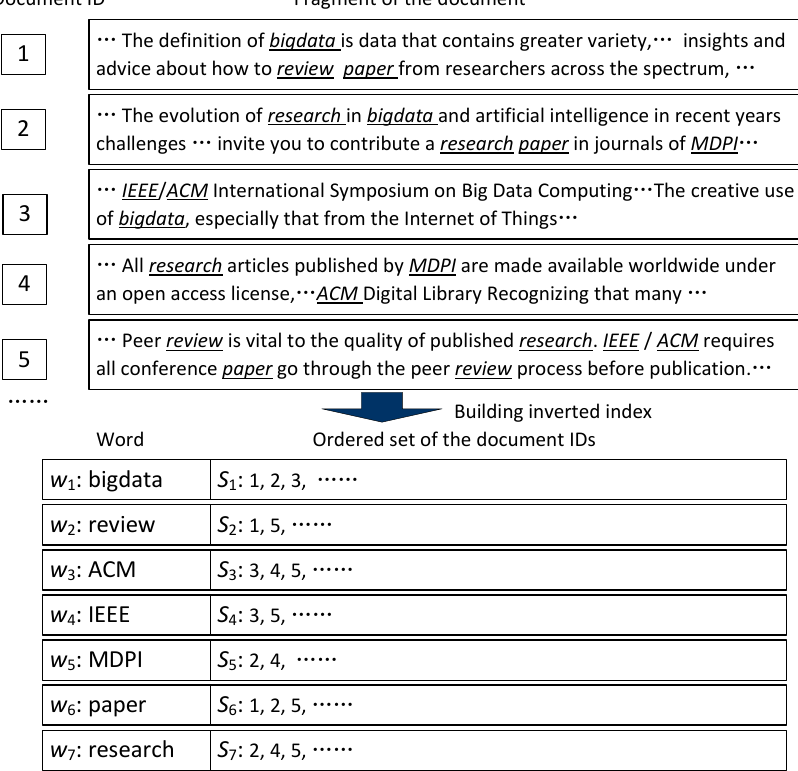
Figure 1. The fragments of sample documents and the inverted